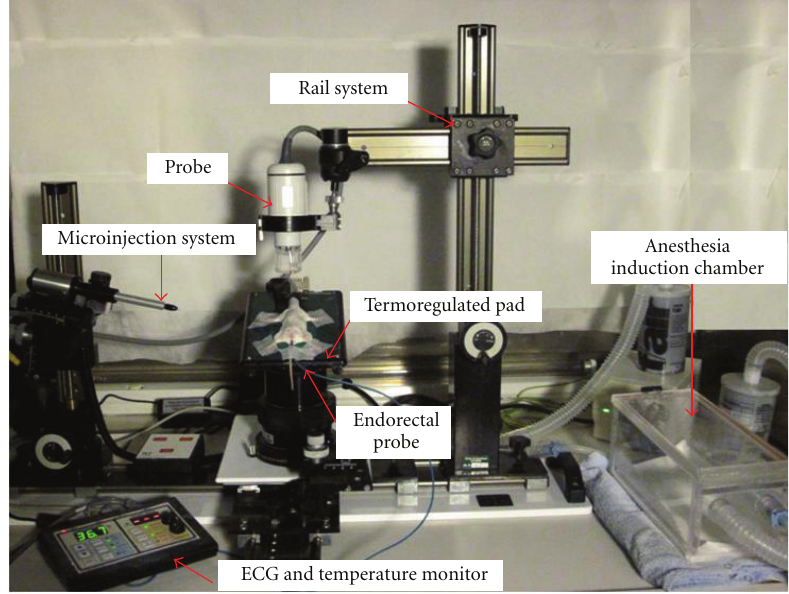
Figure 1: Ultrasound biomicroscopy integrated mechanical support with rail system. The microinjection system for visualization and guidance of injection and extraction procedures in real time. Ultrasound probe is mounted on a system securing the probe in a stationary position when the ultrasound scan is in the desired image plane. After anesthesia, the mouse is positioned on a termoregulated pad to monitor ECG and temperature (with endorectal probe) and ensure mouse comfort during